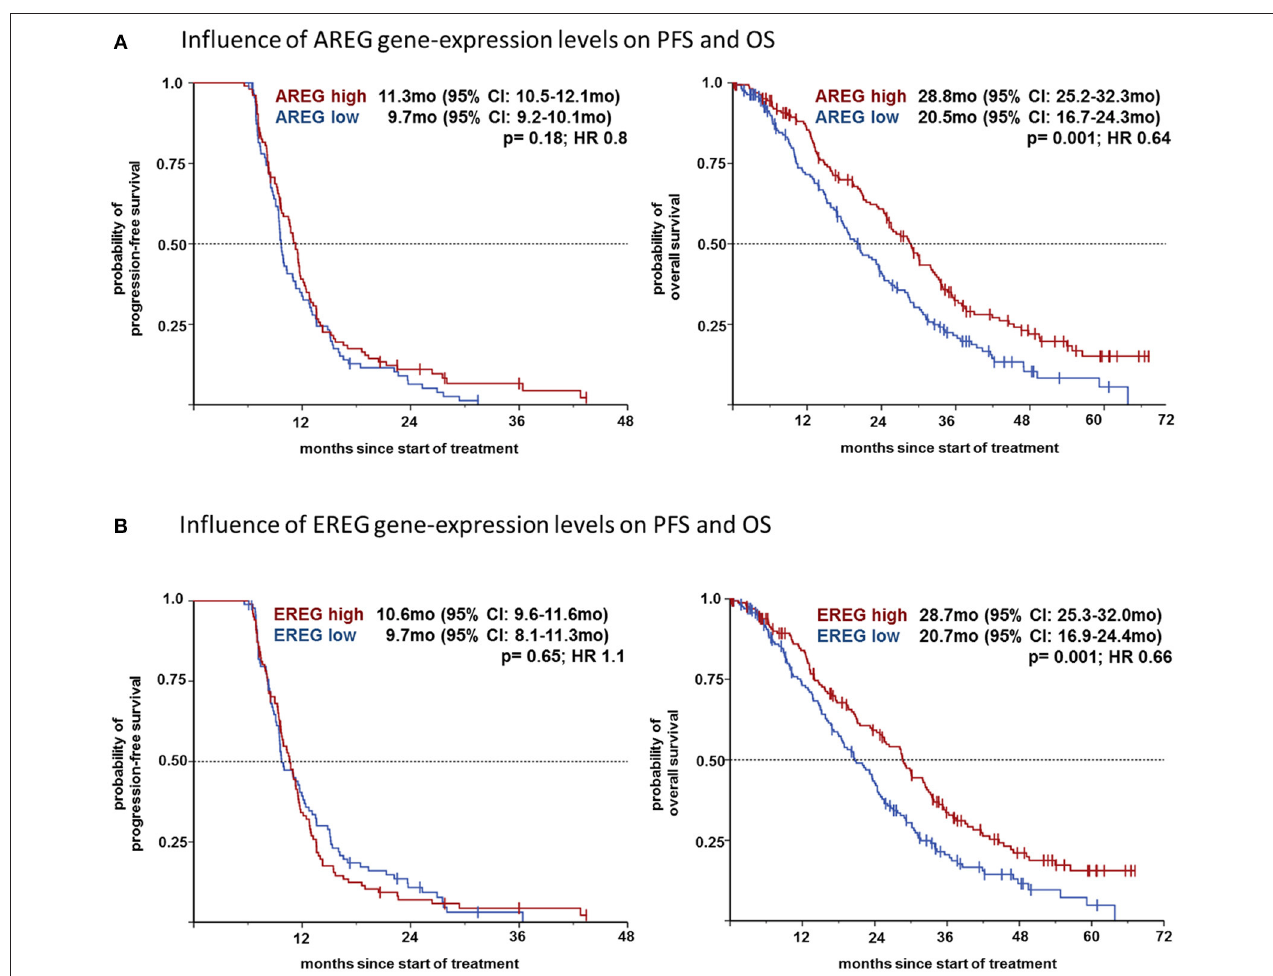
FIGURE 2 | (A) Influence of AREG gene-expression levels on PFS and OS. (B) Influence of EREG gene-expression levels on PFS and OS.